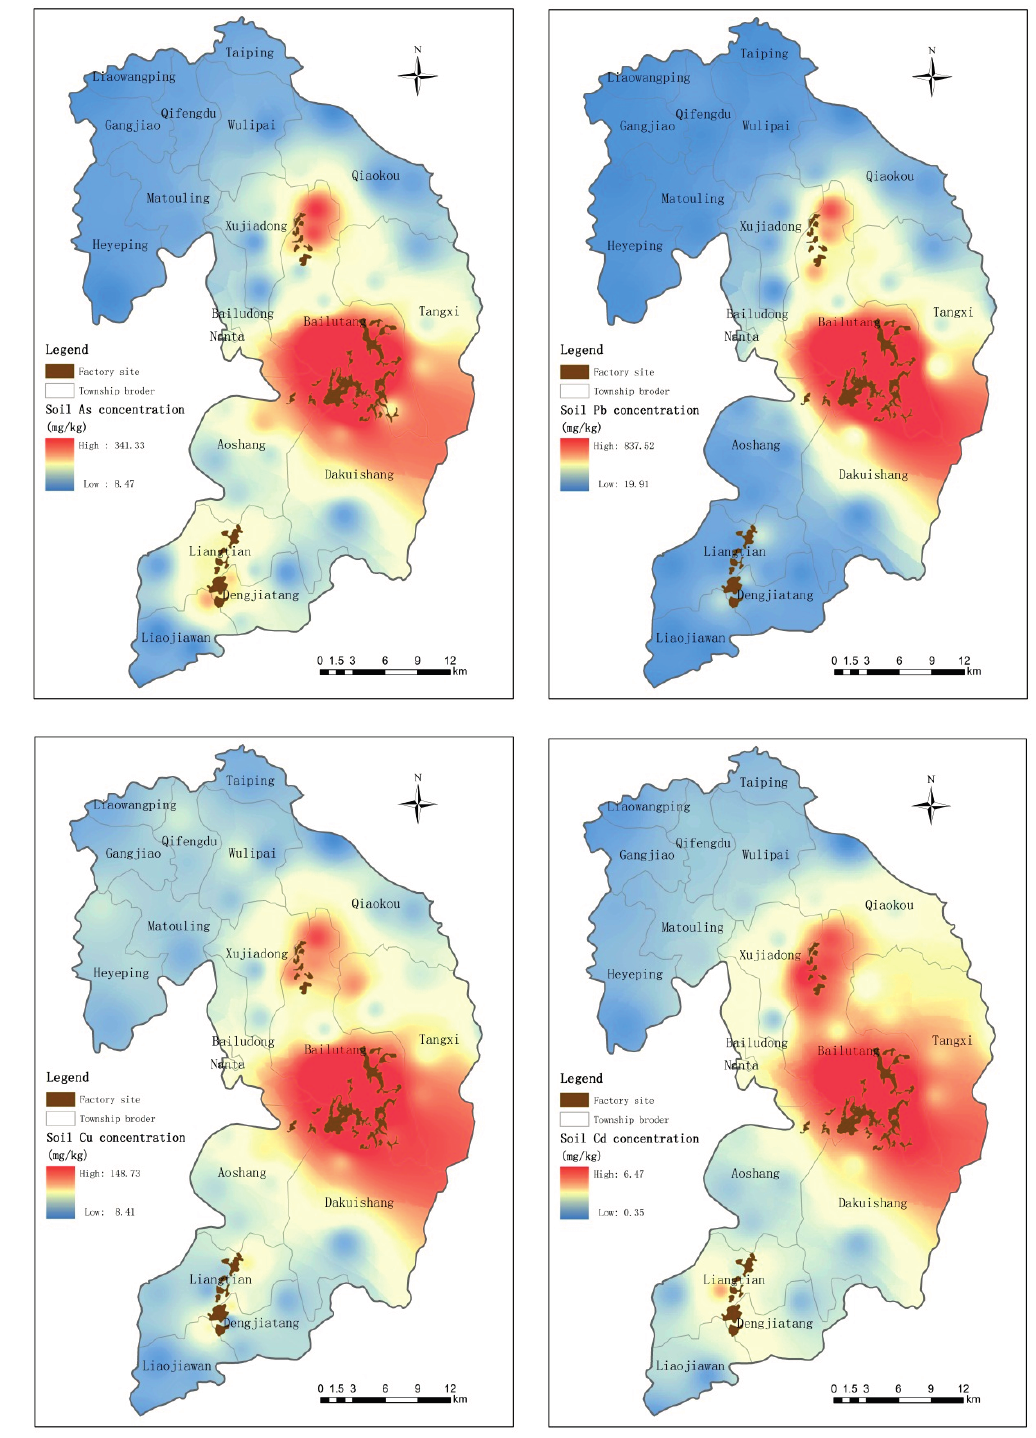
Figure 2. Geographical distribution of As, Pb, Cu and Cd levels in soils from the investigated area. Heavy metal concentrations in most samples collected from Area A, which has been associated with activities at the Shizhuyuan, Dongbo and Manaoshan mines at relatively larger scales and for longer periods, were higher than those from other the other mine industrial areas. At functional areas B and C, the regional ore smelters and metal processing plants are concentrated, and the plants are relatively small in size. However, due to the long-term mining and metallurgical activities at all three functional